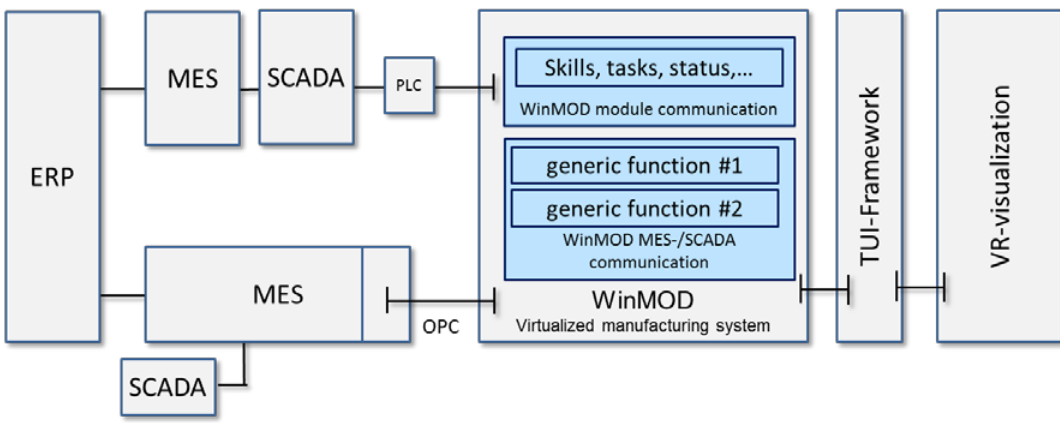
Figure 6. WinMOD behavior model communication with decoupled SCADA and MES-entities and communication with interface modules.